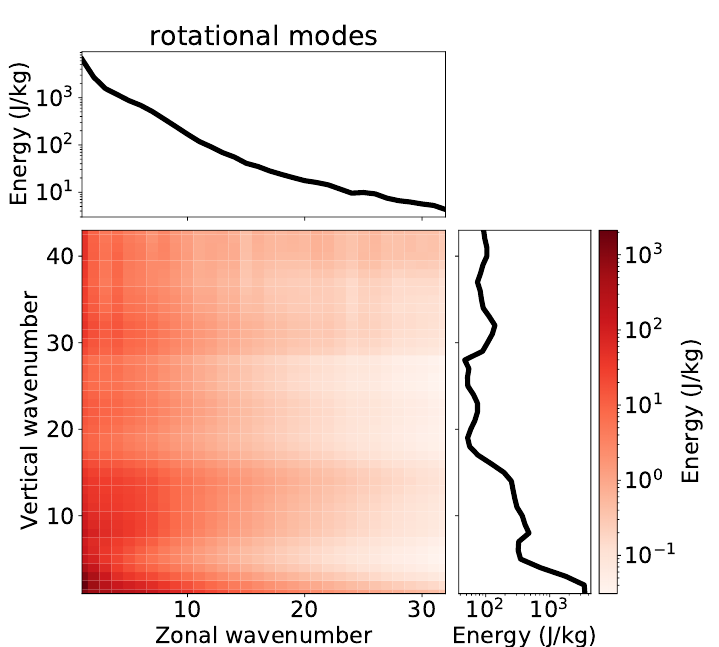
Figure 7. Energy spectrum of the rotational mode component of the atmospheric oscillations as a function of the zonal wavenumber and vertical